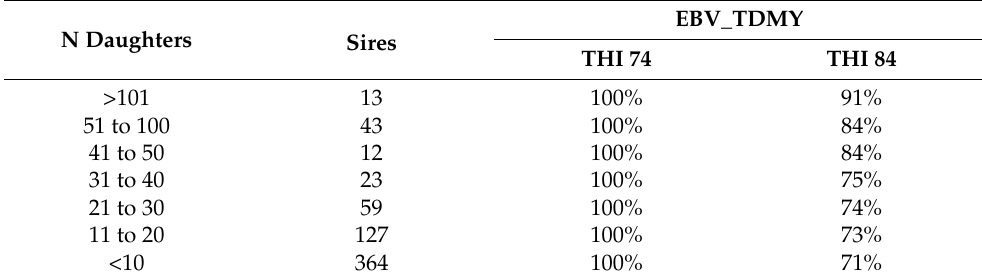
Table 3. Efficiency in estimating breeding value for test-day milk yield (EBV_TDMY) of Brazilian Holstein cattle under conditions of homeostasis and heat